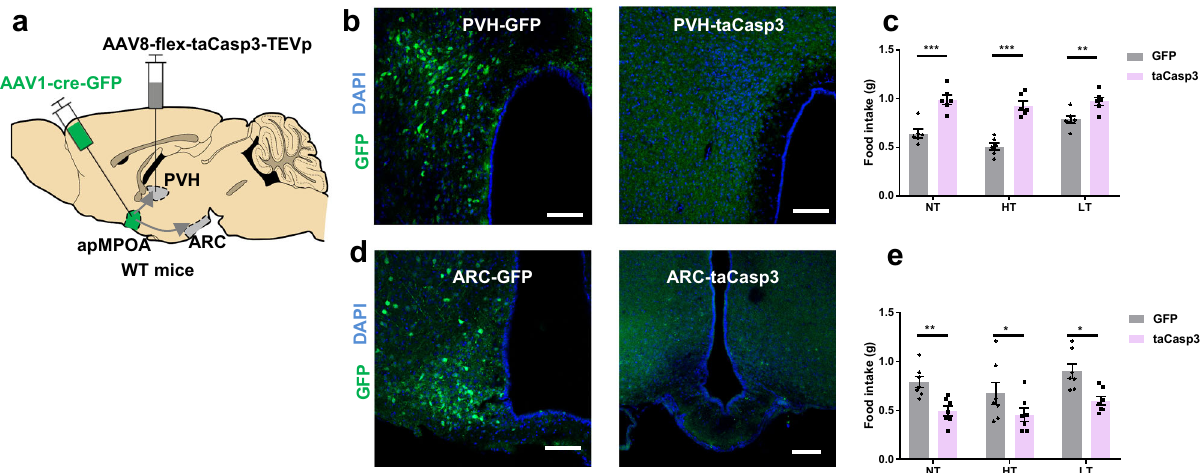
Fig. 4 Genetic ablation on the apMPOA-recipient neurons in ARC/PVH reversely modulate feeding behavior. a Schematic image showing genetic ablation of apMPOA-recipient neurons in ARC/PVH individually (PVH shown here) in wild type mice by injecting anterograde transsynaptic AAV1-Cre- GFP in apMPOA, and Cre-dependent caspase-3 in the ARC and PVH. b , d Representative images showing preserved transsynaptic neurons in PVH (upper left image) and ARC (lower left image) that expressed GFP in the control group, but ablated transsynaptic neurons in the PVH (upper right image) and ARC (lower right image) in taCasp3-injected mice. Scale bar, 100 µ m. c The ablation of transsynaptic neurons in the PVH signi fi cantly increased food intake compared to that in the controls in all thermal conditions. Interaction effect: F 2,9 (temperature × treatment) = 10.67, ** p = 0.004; main effect: F 2,9 (temperature) = 25.85, *** p < 0.001; F 1,10 (treatment) = 42.42, *** p < 0.001. Pairwise comparisons showed that caspase ablating apMPOA-recipient PVH neurons increased food intake in all thermal conditions (*** p < 0.001, ** p = 0.01). Within-group tests showed signi fi cant simple effect of temperature in control group (F(2,9) = 34.52,*** p < 0.001), but not in the taCasp3 group (F(2,9) = 2.0, p = 0.191). Two-way repeated-measure ANOVA and post hoc LSD multiple comparison, n = 6 animals for each group. e The ablation of transsynaptic neurons in the ARC signi fi cantly decreased food intake compared to that in the controls in all thermal conditions. Interaction effect: F 2,11 (temperature × treatment) = 0.63, p = 0.55; main effect: F 2,11 (temperature) = 16.4, *** p = 0.001; F 1,12 (treatment) = 9.35, ** p = 0.01. Pairwise comparisons showed that caspase ablating apMPOA-recipient ARC neurons decreased food intake in all thermal conditions (*** p < 0.001, ** p = 0.005). Within-group tests showed signi fi cant simple effect of temperature in the control group (F(2,11) = 11.39,** p = 0.002), and the taCasp3 group (F(2,11) = 5.64, * p = 0.021). Two-way repeated-measure ANOVA and post hoc LSD multiple comparison, n = 7 animals for each group. All error bars show